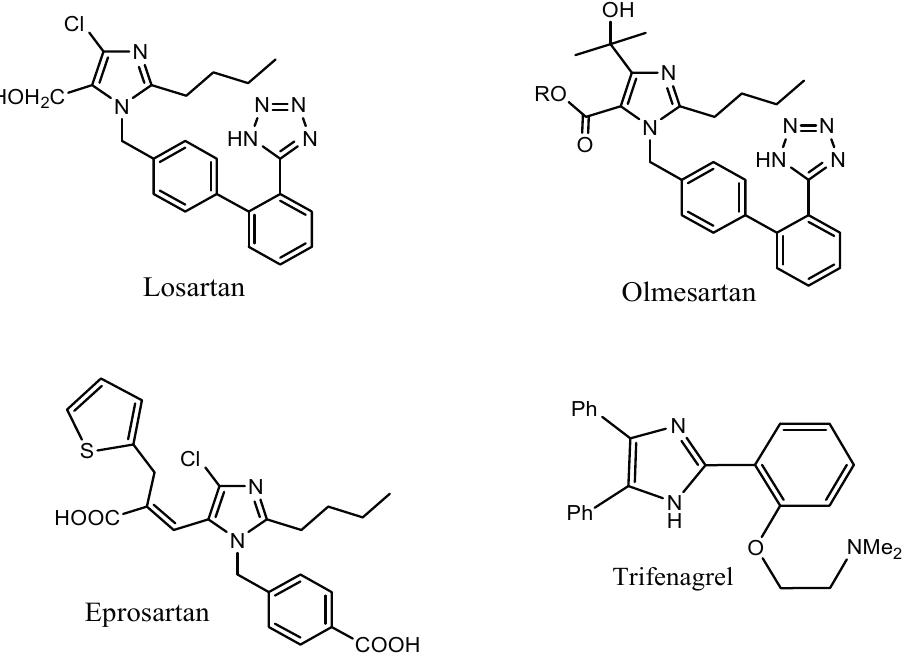
Figure 1. Some of the imidazole based